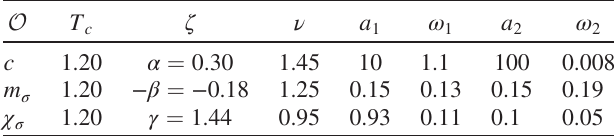
EMERGENT POTTS ORDER IN A COUPLED HEXATIC-NEMATIC TABLE II. Universal scaling exponents and critical temperature T c extracted from finite-size-scaling analysis of shown in Fig. 7. We use the scaling form presented in Eq. (5.1), which includes corrections to scaling. The 2D Potts critical exponents are α ¼ 1 = 3 , β ¼ 1 = 9 ≈ 0 . 11 , γ ¼ 13 = 9 ≈ 1 . 44 , and ν ¼ 5 = 6 ≈ 0 . 83 , which is in fair agreement with our findings with the exception of ν . Note that when tracking only T 3 , and including small system sizes, we obtain a value of ν that lies much closer to its expected value, a conclusion [Fig. 6(a)].